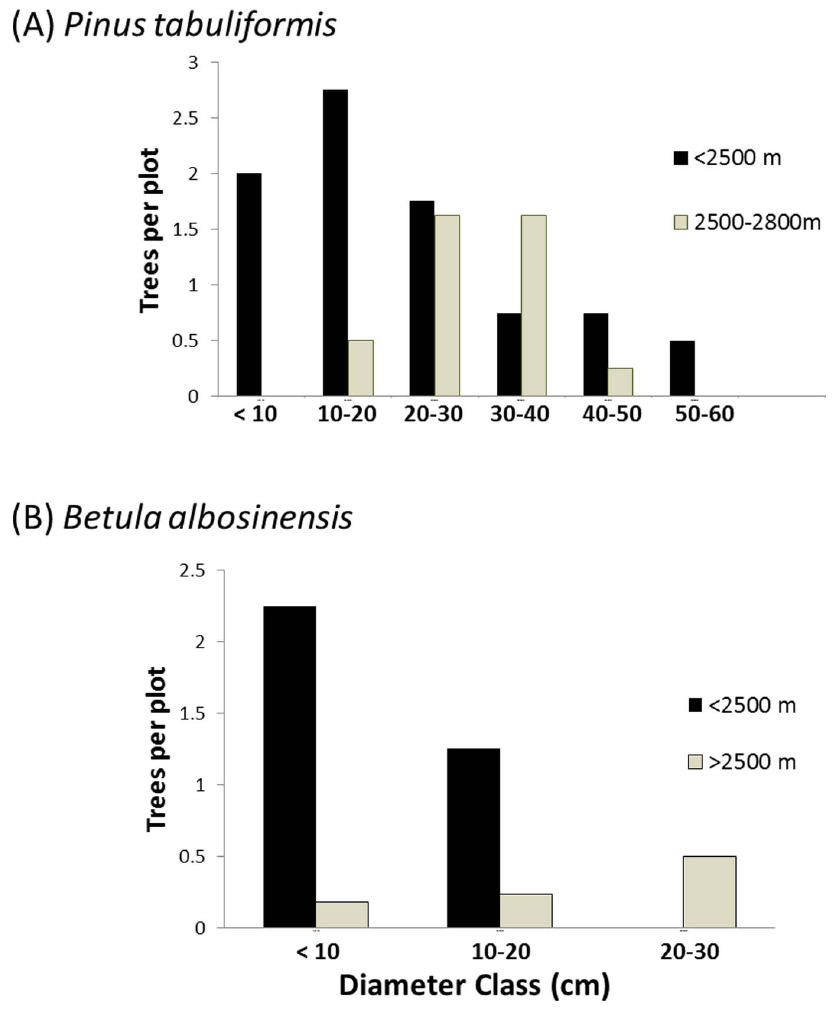
Figure 5. Diameter class distributions of dominant trees in Jiuzhaigou National Nature Reserve by elevation. Plots of (A) overstory trees of Pinus tabuliformis and (B) sub-canopy trees of Betula albosinensis in, segregated into elevation class. P. tabuliformis was found in 5 of 28 sampled plots, including 3 of the 4 plots sampled in the lowest elevation class (2275– 2500 m), and 2 of the 8 plots in the next lowest elevation category (2500–2800 m). B. albosinensis was found in 7 of 28 plots, including 1 of the 4 plots in the lowest elevation class and 6 of 17 plots between 2500 and 3100 m.